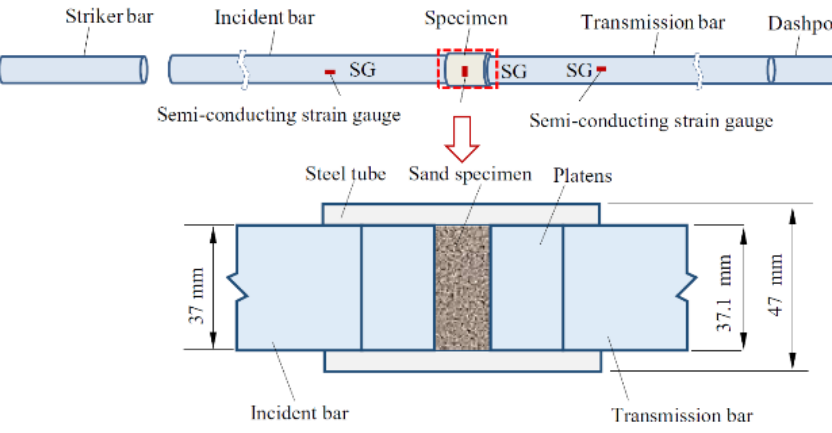
Figure 19. SHPB test system with sand specimen (reprinted from Ref. [84]).